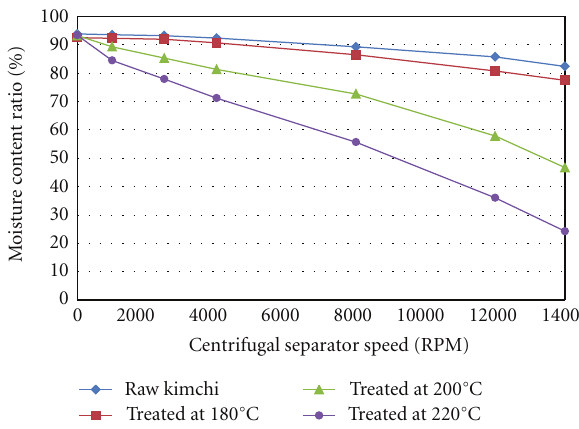
Figure 2: Dehydration performance of raw kimchi and its hydrothermal